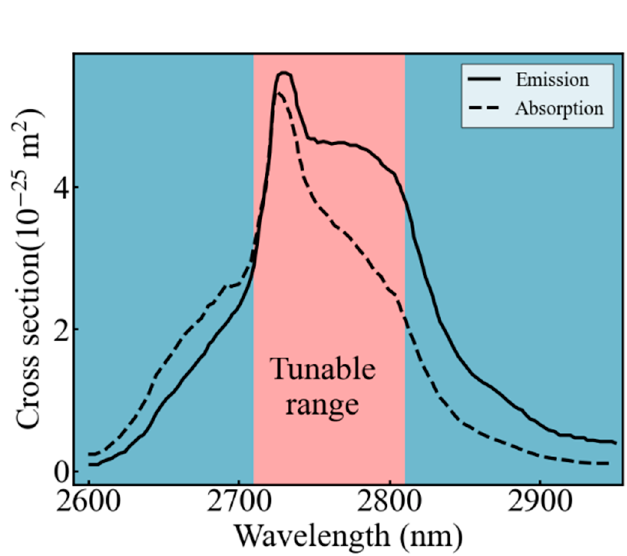
Figure A1. The emission and absorption cross-section of Er 3+ as a function of emission wavelength. Experimental data from [28].